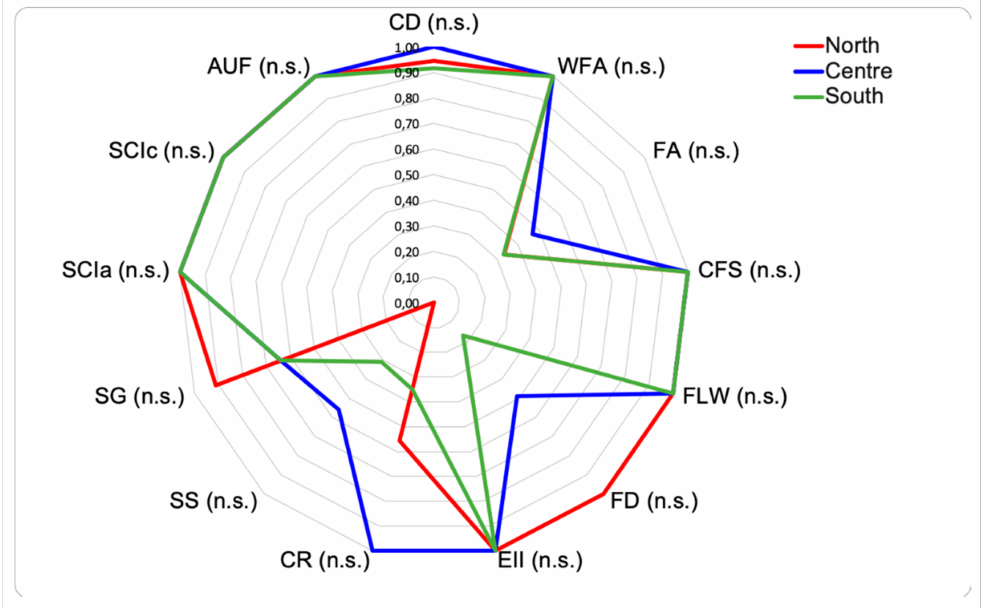
Figure 2. Discrepancy of the indicators’ values between geographical